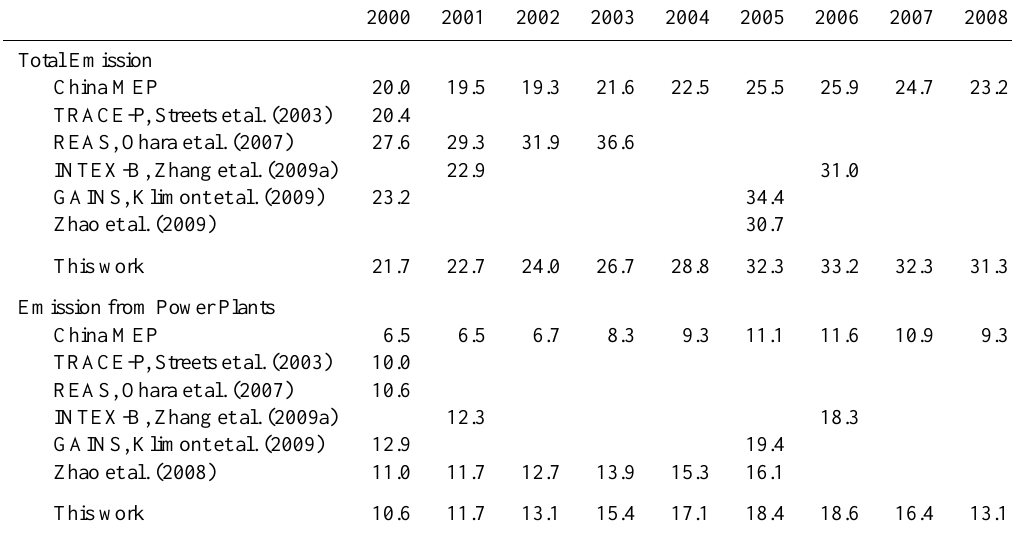
Table 3. Comparison of SO 2 emission estimates for China, 2000–2008 (unit: Tg/year).